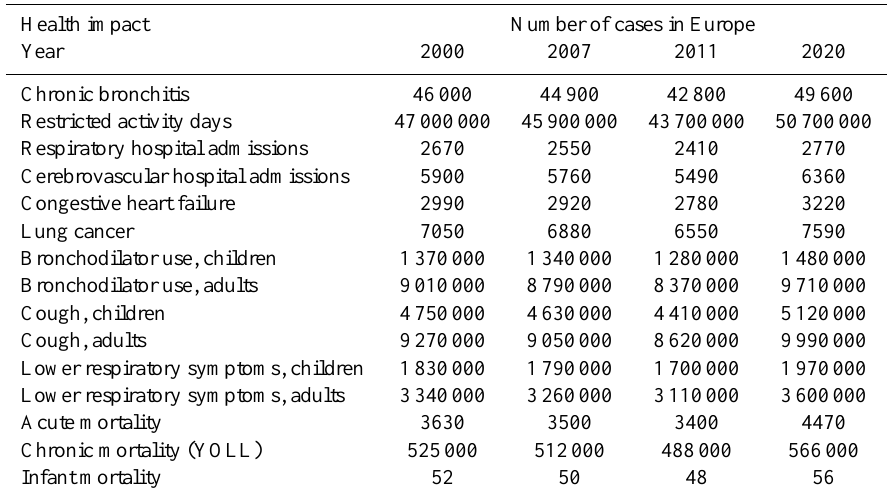
Table 2. Total number of cases in Europe of the different impacts related to international ship traffic in the Northern Hemisphere (scenario: All/15) for the four different years.